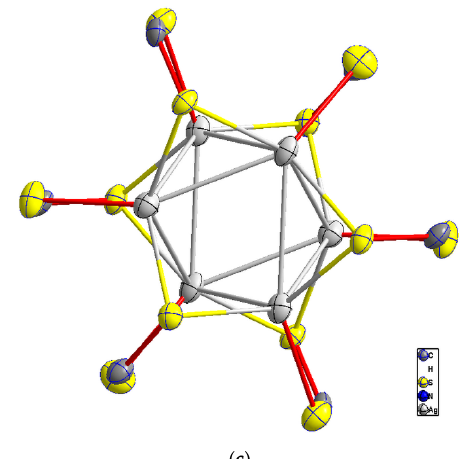
Figure 2. ( a ) Asymmetric unit of complex 1 . Hydrogen atoms and 2,6-diisopropyl units of the ligands are omitted for the sake of clarity ( b ) Octahedral arrangement of Ag atoms in 1 ( c ) Propeller like core of CS 2 moieties in 1 . Thermal displacement ellipsoids are drawn for all atoms at the 50 % probability level. Comparison of 1 to Ag 6 [CS 2 (2,6- i Pr 2 C 6 H 3 NC(H)=NC 6 H 3 - i Pr 2 )] 6